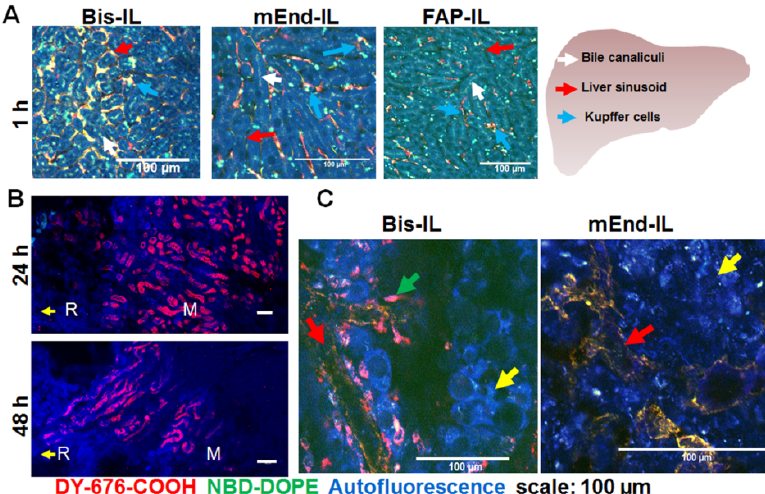
Figure 7. The bispecific liposomes localize in the liver within the sinusoids and Kupffer cells and in the tumors within the tumor vessels and myofibroblasts. ( A ) Microscopic images of fresh liver excised 60–70 min post injection. Bi-FAP/mEnd-IL (Bis-IL) signals locate predominantly in the sinusoids ( red arrow ), Kupffer cells ( blue arrow ) and bile canaliculi ( white arrow ), while the mEnd-IL fluorescence is seen in the sinusoids, and to a lower extent in Kupffer cells and bile canaliculi. FAP-IL signals are seen mainly in the Kupffer cells and bile canaliculi. ( B ) Representative microscopic image of the kidneys 24 h and 48 h post injection of Bi-FAP/mEnd-IL. “R” depicts the renal cortex and “M” the renal medulla. ( C ) Representative microscopic images of the MDA-MB231 xenograft showing Bi-FAP/mEnd-IL-based red fluorescence in the tumor vasculature ( red arrow ) and tumor myofibroblasts ( blue arrow ) and mEnd-IL based fluorescence only in the tumor vasculature. The tumor cells show only the tissue-specific blue autofluorescence ( yellow arrow ).